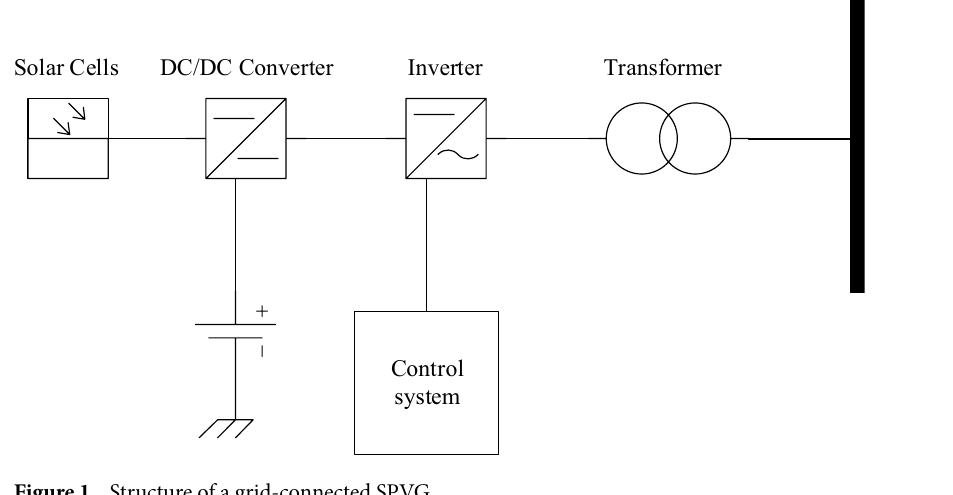
Figure 1. Structure of a grid-connected